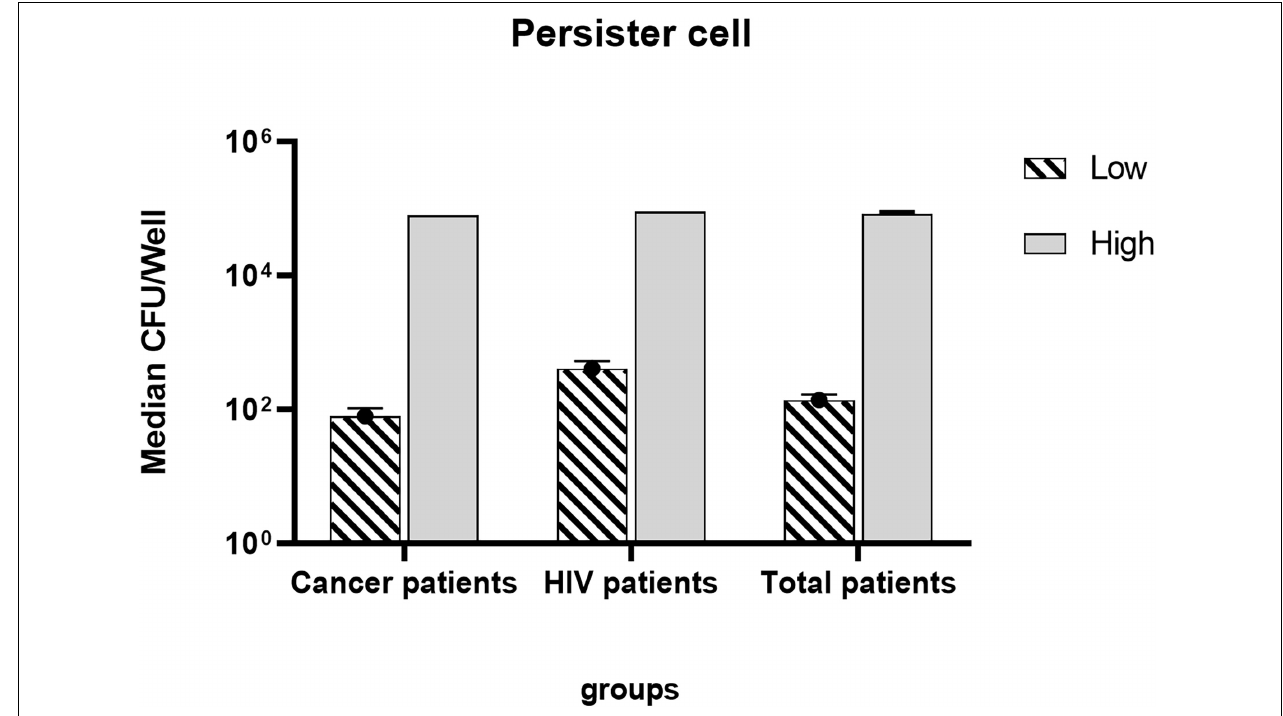
FIGURE 3 | Log mean persister production in patients undergoing chemotherapy and HIV